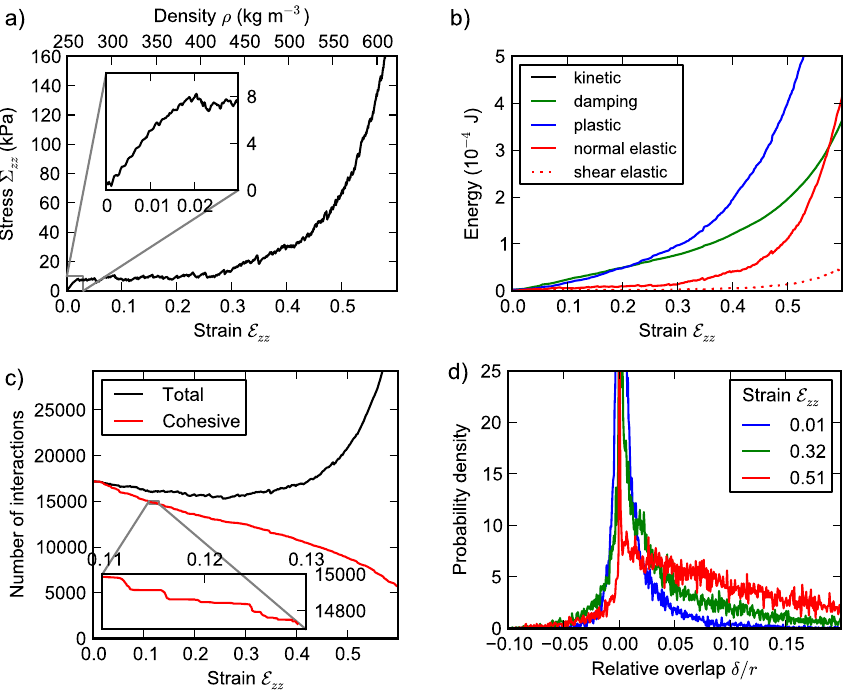
Figure 5. Results of the model applied to sample s-RG1 (rounded grains) with the parameters listed in Table 2: (a) macroscopic stress–strain curve, (b) evolution of energy components with strain, (c) total number of bonds and number of cohesive bonds as a function of strain and (d) occurrence distribution of the relative grain overlap for three different imposed strains.